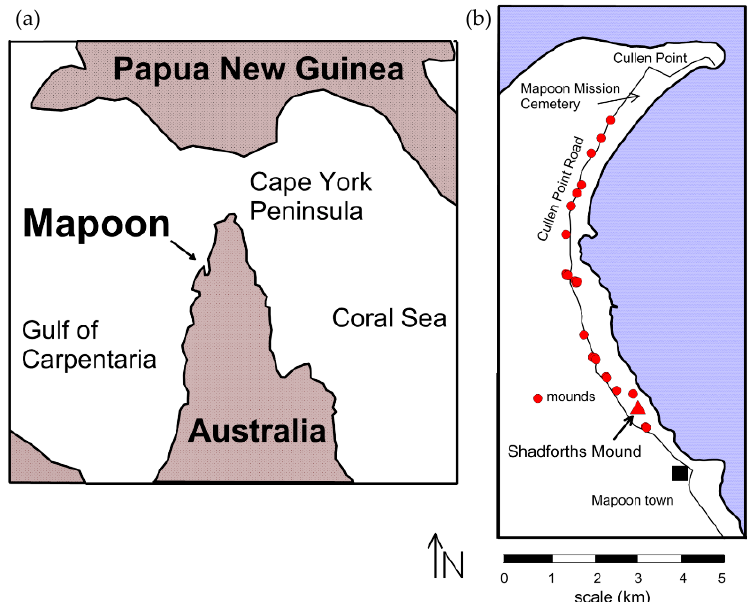
Figure 1. Base map of the Mapoon area, northern Australia, where a number of mounds have been found that are the basis for this study. ( a ) Mapoon location in northeast Australia ( b ) Mound locations near Mapoon.